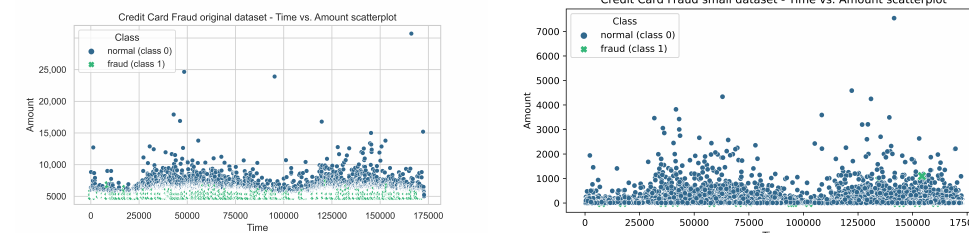
Figure 2. In order to emphasize the fraudulent transactions, the marker size for class 1 is set as four times bigger than the size for class 0.